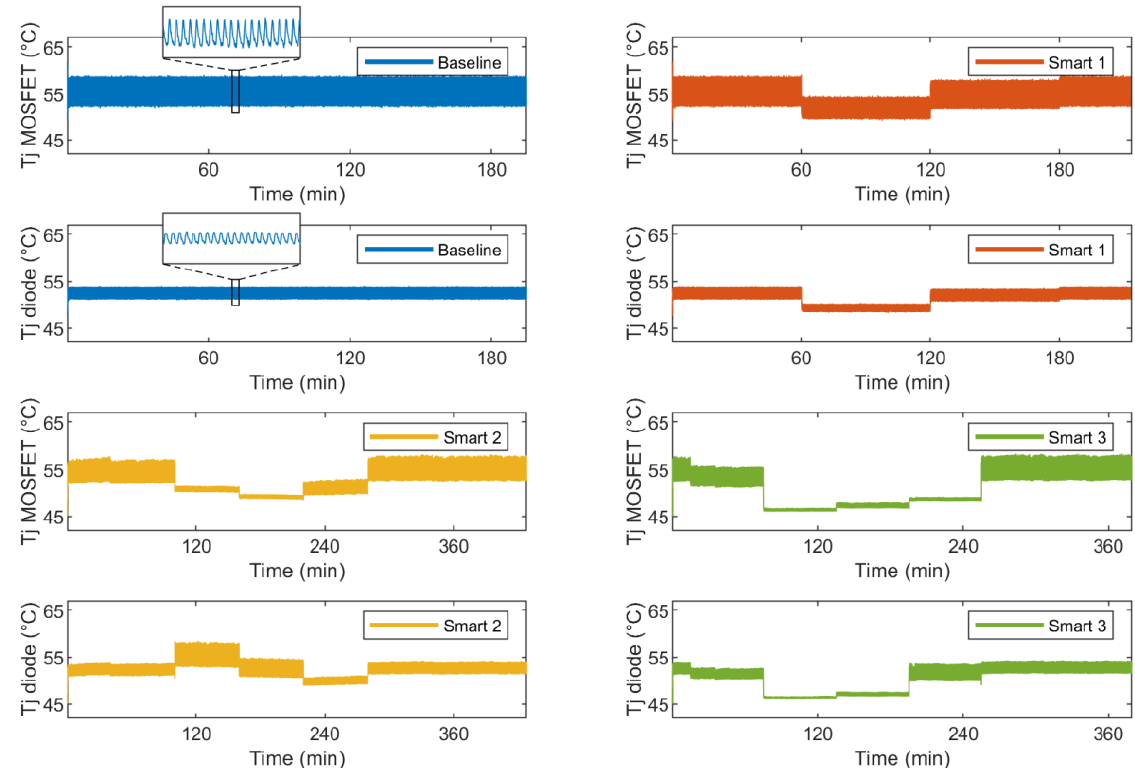
Figure 7. Junction temperature profiles of the MOSFET and the body diode for the applied charging current profiles.